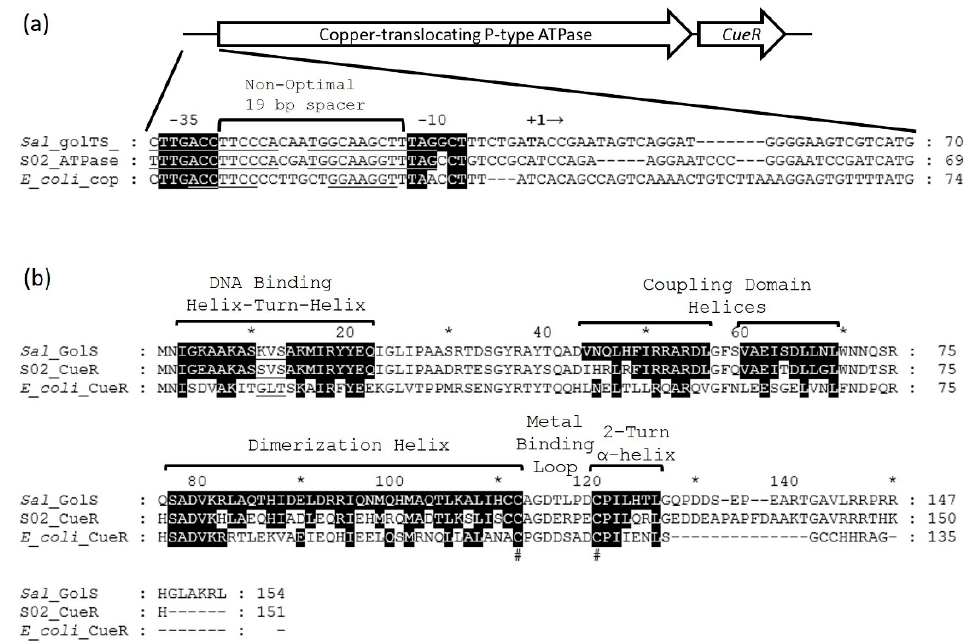
Figure 5. The S. maltophilia 02 copper translocating P-type ATPase gene and CueR activator/repressor switch. ( a ) The S. maltophilia 02 copper translocating P-type ATPase gene and its predicted promoter region using the S. enterica golT , and the E. coli copA promoter regions. The gene for cueR is adjacent to and transcribed after the ATPase gene in S. maltophilia 02. The promoter region contains a non-optimal 19 bp spacer region and a CueR binding site (underlined) between the predicted − 10 and − 35 regions. Identical nucleotides in the − 10 and − 35 regions are highlighted in black. The last three base pairs, ATG, on the far right marks the beginning of ATPase translation. ( b ) Prediction of the S. maltophilia 02 CueR secondary structure using the S. enterica GolS and the E. coli CueR amino acid residue primary sequences. Like MerR, the CueR helix-turn-helix domain binds to the operator region of the promoter in the DNA. The coupling domain links the DNA binding domain to the metal binding domain. The metal binding domain consists of a dimerization helix, metal binding loop and 2-turn α -helix. The amino acids residues that are highlighted in black are identical to amino acid residues in the helices of E. coli CueR. The # below the sequences designates cysteine amino acid residues which bind to Au(I) and Cu(I). The * and numbers above the Gols and CueR primary sequences denote the position of every 10 amino acid residues.